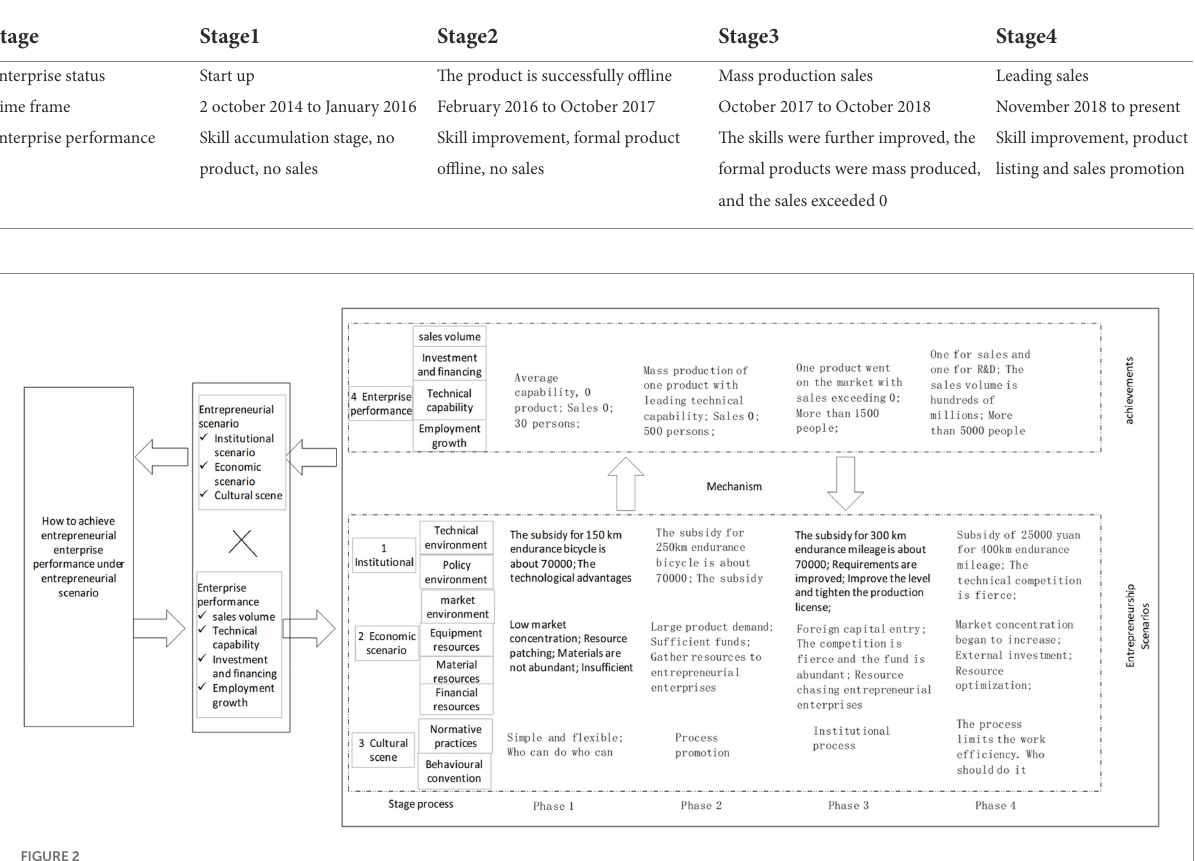
TABLE 4 Division of entrepreneurial process stages of company A.